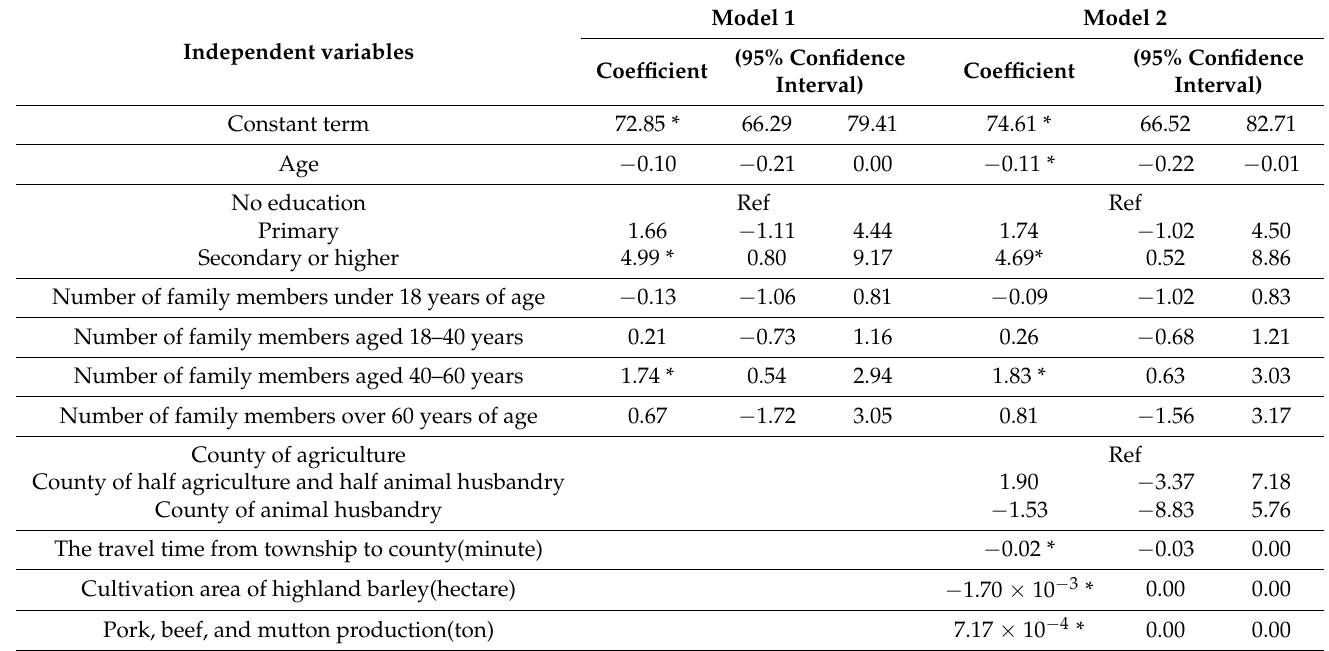
Table 4. Hierarchical linear model of influencing factors related to food consumption